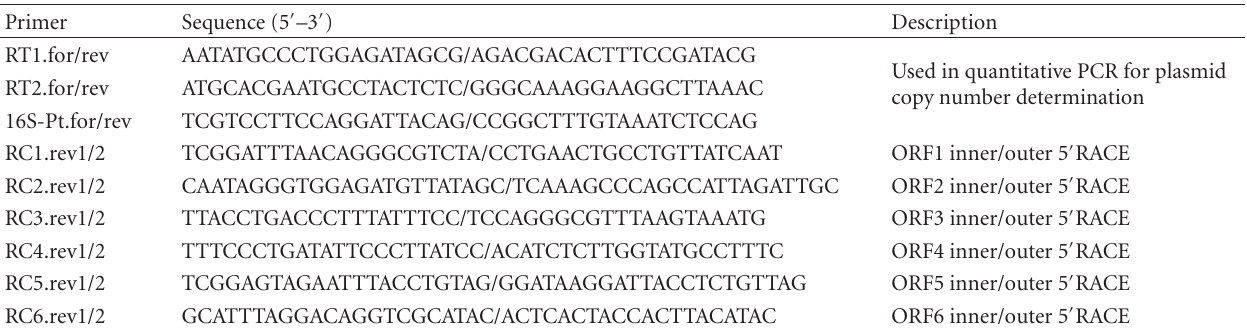
Table 1: Oligonucleotides used in this